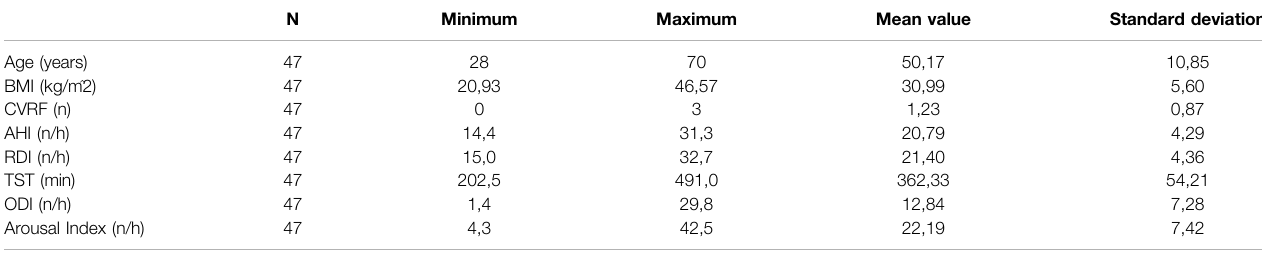
TABLE 1 | The epidemiological data of the 47 patients with AHI > 30/h shows age in years, BMI in kg/m 2 , CVRF for the number of cardiovascular risk factors (hypertension, obesity, diabetesmellitus, hyperlipoproteinemia), AHI innumber per hour, RDI (Respiratory DisturbanceIndex) in number per hour, TST (total sleeptime)in minutes, ODI (oxygen desaturation index) in number per hour and Arousal Index in number per hour.